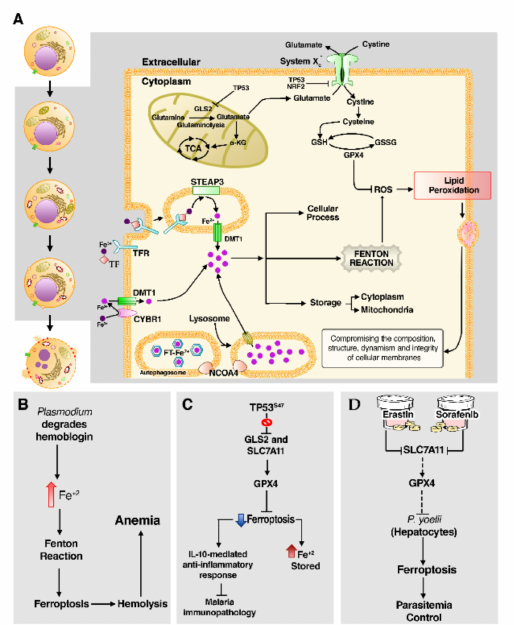
Figure 6. The emerging effect of ferroptosis in malaria immunity. ( A ) An overview of the ferroptosis pathway. On the left side of the figure (white background), morphologically, ferroptotic cell death is distinguished by structural changes in mitochondria like outer membrane disruption and volume reduction as well as cell rounding followed by plasma membrane rupture. On the right, the genetic regulatory routes of ferroptosis. ( B ) The consumption of hemoglobin by Plasmodium releases Fe 2+ atoms that may catalyze the Fenton reaction, causing iron–lipid peroxidation and hemolysis, this pro- cess being involved in anemia. ( C ) Variant S47 of TP53 impair ferroptosis, causing iron accumulation in macrophages, which elevates IL-10 levels and provides an anti-inflammatory response, limiting the immunopathological damage of malaria. ( D ) On the other hand, the induction of ferroptosis